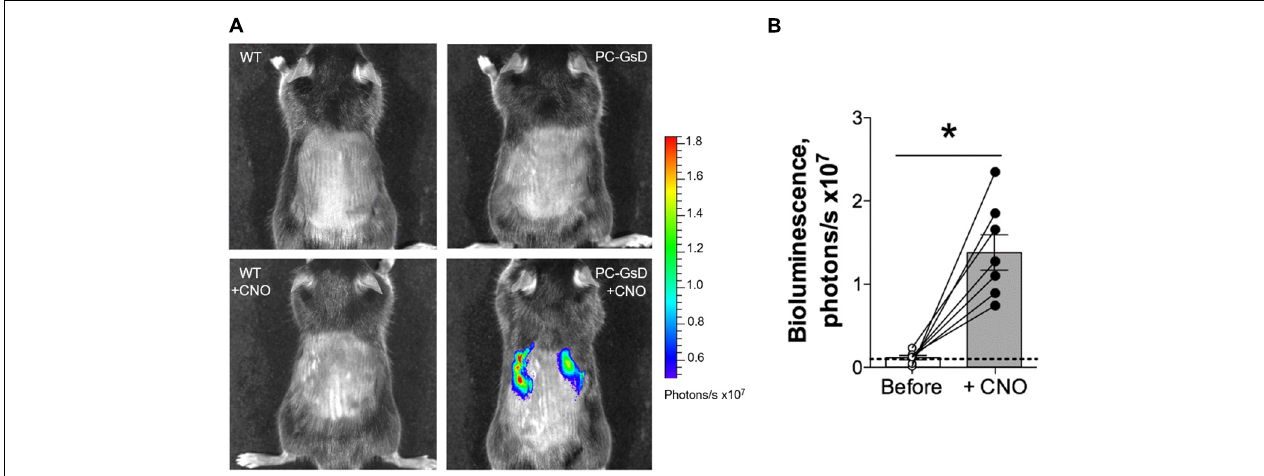
FIGURE 2 | CNO stimulates cAMP-signaling exclusively in the kidneys of PC-specific GsD mice. (A) Micrographs showing representative in vivo bioluminescence (pseudo-colored for intensity) in control (left) and PC-specific GsD (right) mice before (top) and after (bottom) treatment with CNO (10 mg/kg, 6 h). (B) Summary graph of paired data for bioluminescence (photons/s × 10 7 ) in PC-specific GsD mice before (white circles) and after (black circles) treatment with CNO. Bioluminescence in WT mice in the absence and presence of CNO was never greater than background (not shown). Dashed line indicates background level. Data from experiments ( n = 7 mice) identical to those shown in (A) . * P < 0.05 vs. before.